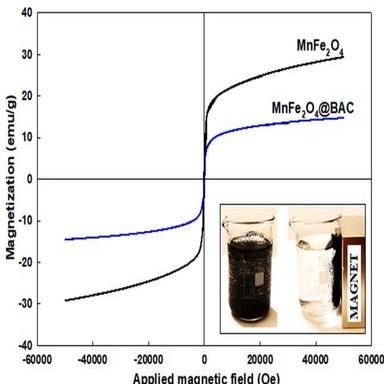
Magnetic hysteresis loops of MnFe2O4@BAC and MnFe2O4 nanoparticles, and photograph (inset) of sorption system before and after magnetic separation.